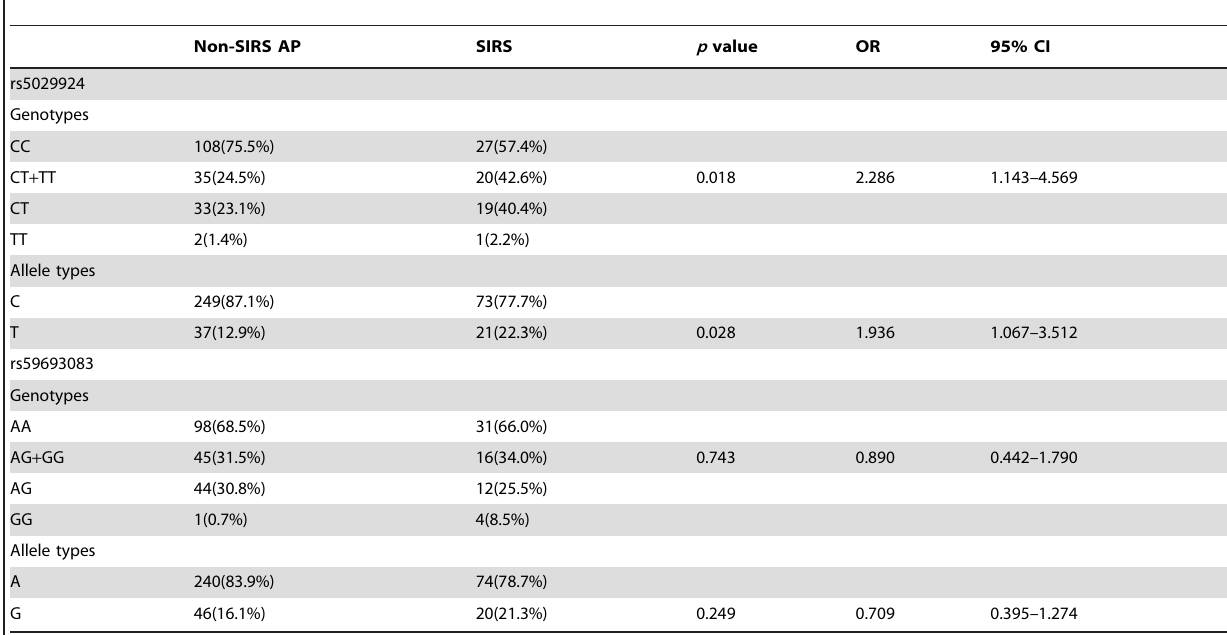
Table 4. Genotype and allele frequencies of TNFAIP3 promoter variants in AP patients with and without SIRS.